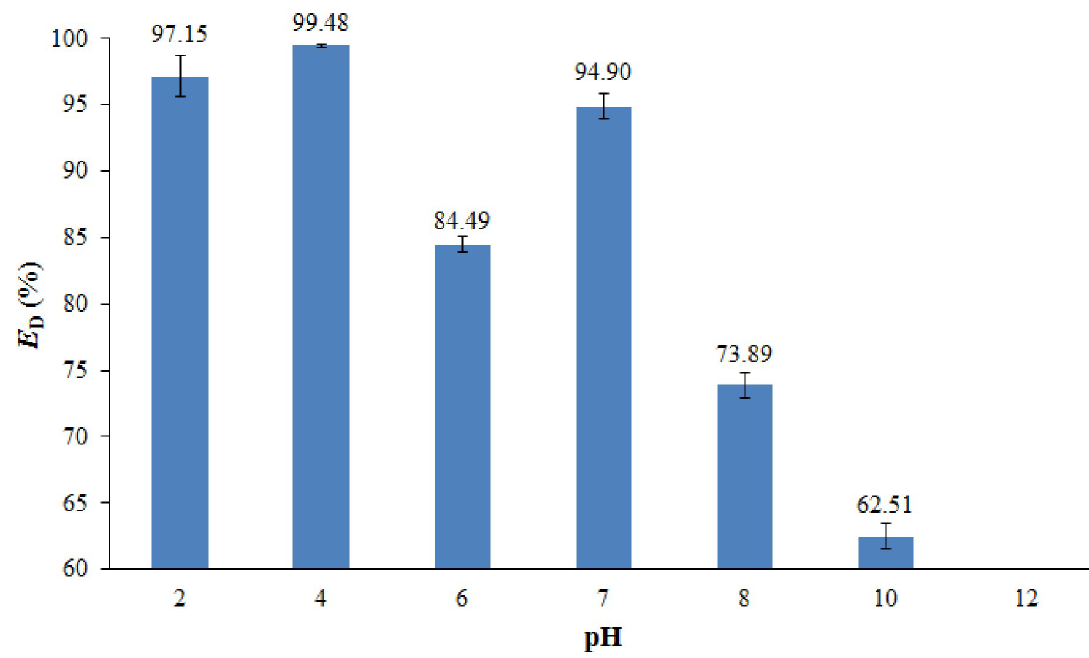
Fig 11. Effect of the crude O/W emulsion pH on E D